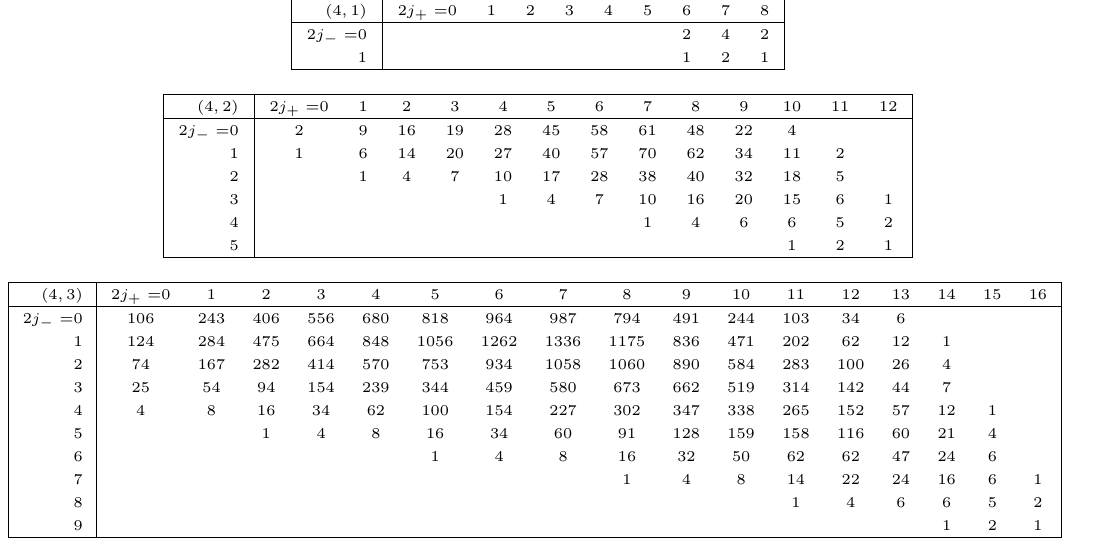
Table 14 . BPS numbers of massless M-string at base degree 4 and fiber degree up to